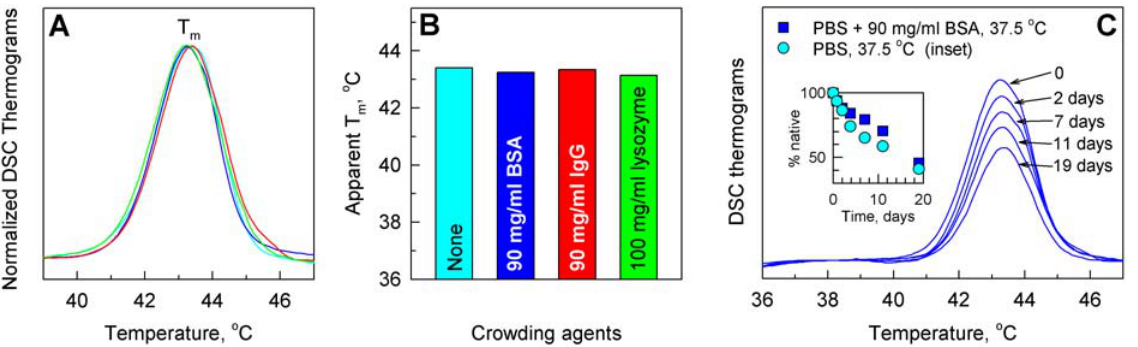
Figure 3. ER-like molecular crowding with nonspecific proteins does not affect procollagen thermal stability. A and B. Normalized DSC thermograms (A) and apparent T m (B) at 1 u C/min heating in PBS without and with 90 mg/ml BSA, 90 mg/ml IgG, or 100 mg/ml lysozyme (the thermograms in A and the corresponding bars in B have the same colors). C. Unfolding kinetics of procollagen at 37.5 u C. In PBS with 90 mg/ml BSA, native procollagen fractions (inset, squares) were measured from the area under 1 u C/min DSC thermograms of sample aliquots (blue tracings). In PBS without BSA, native procollagen fractions were measured from CD as shown in Fig. 1B. doi:10.1371/journal.pone.0001029.g003 and 0.5 mM MgCl 2 , TBS (50 mM Tris, 0.15 M NaCl, pH 7.4), and TBS with 10 mM CaCl 2 were identical.